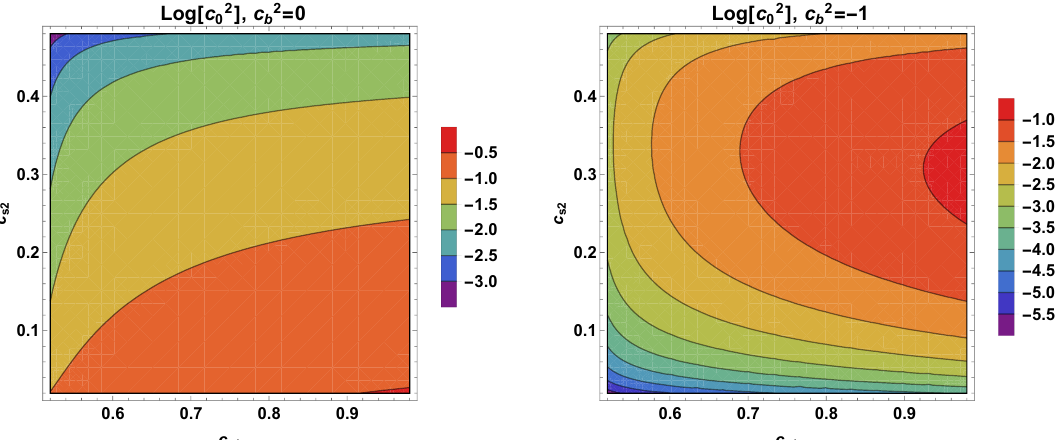
logarithmic contour plot for c 2 Figure 5. c 2 0